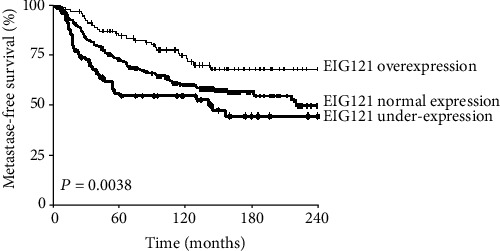
Relations between metastasis-free survival (MFS) and MDGI, MIG6, and EIG121 gene mRNA levels. The difference in MFS among patients with downregulated, normal, and upregulated EIG121 expression was statistically significant (p = 0.0038).